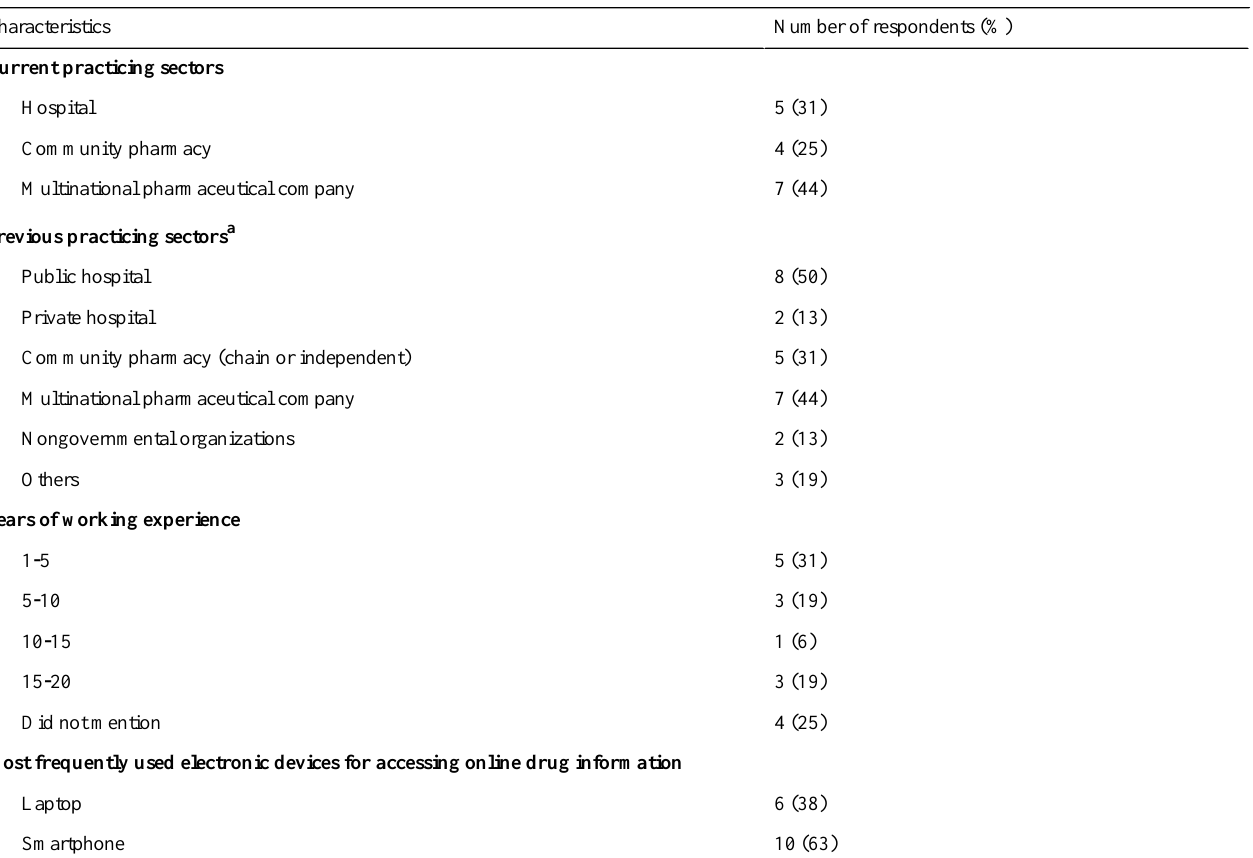
Table 1. Characteristics of study population (N=16).